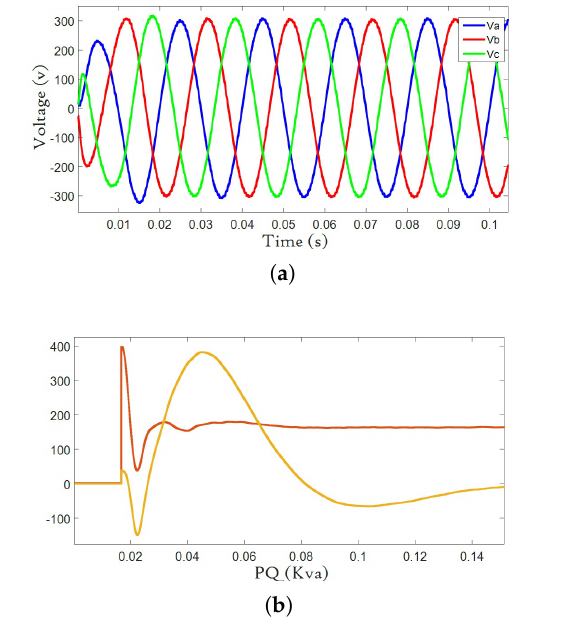
Figure 14. ( a ) Three-phase voltage and ( b )